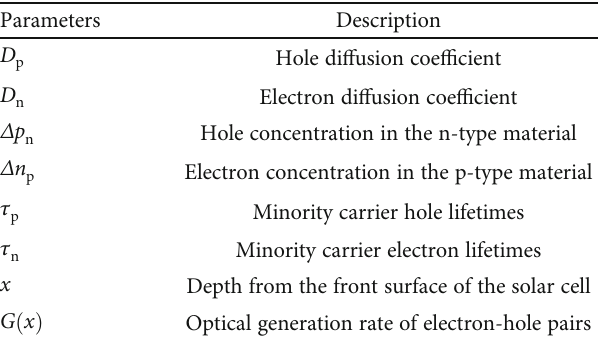
Figure 3: The electric performance and EQE for GaAs solar cells irradiated with 150keV proton: (a) degradation of I (b) EQE.